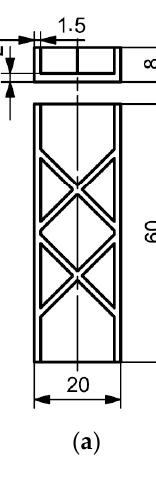
Figure 9. XX-rib specimen geometry: ( a ) Specimen, technical drawing with main dimensions; ( b ) 3D model of and FLM-printed XX-rib specimen; ( c ) Bending load case for XX-rib specimen as applied in FE simulation. All contacts modeled using a coefficient of friction of µ = 0.3.